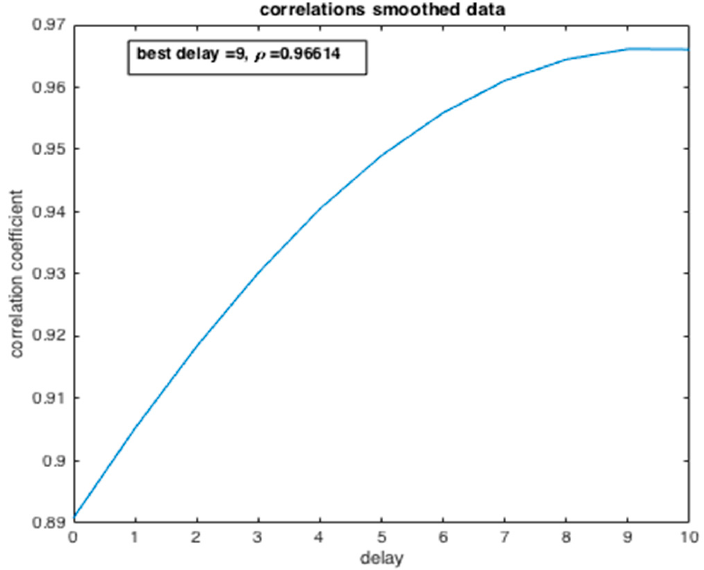
Figure 18. Evolution of the correlation coefficient of the number of confirmed cases (I) and the number of deaths (R).